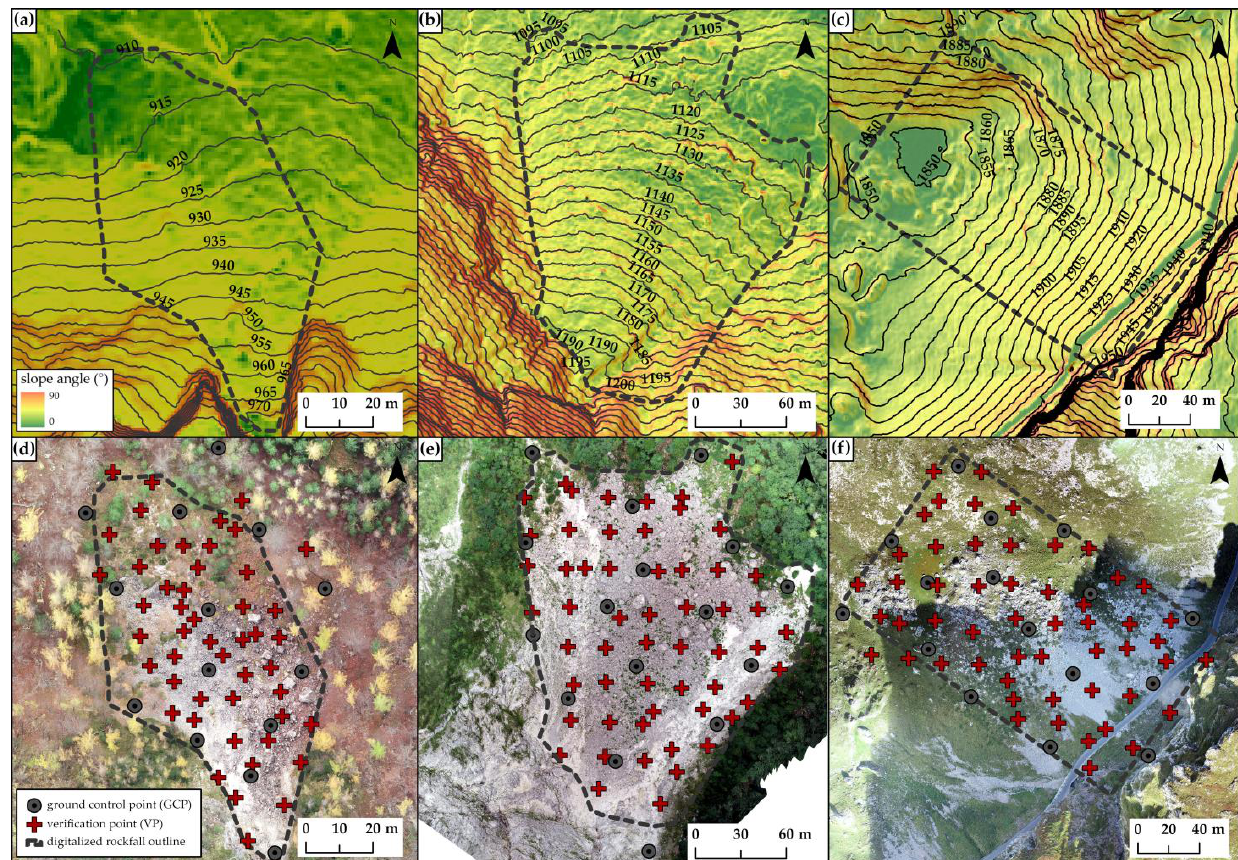
Figure 3. Elevation and slope characteristics of studied areas ( a – c ) with the drawn locations of the verification points (VPs), ground control points (GCPs), and digitalized rockfall runout areas ( d – f ) at Kekec ( a , d ), Krnica ( b , e ), and Mangart ( c , f ).